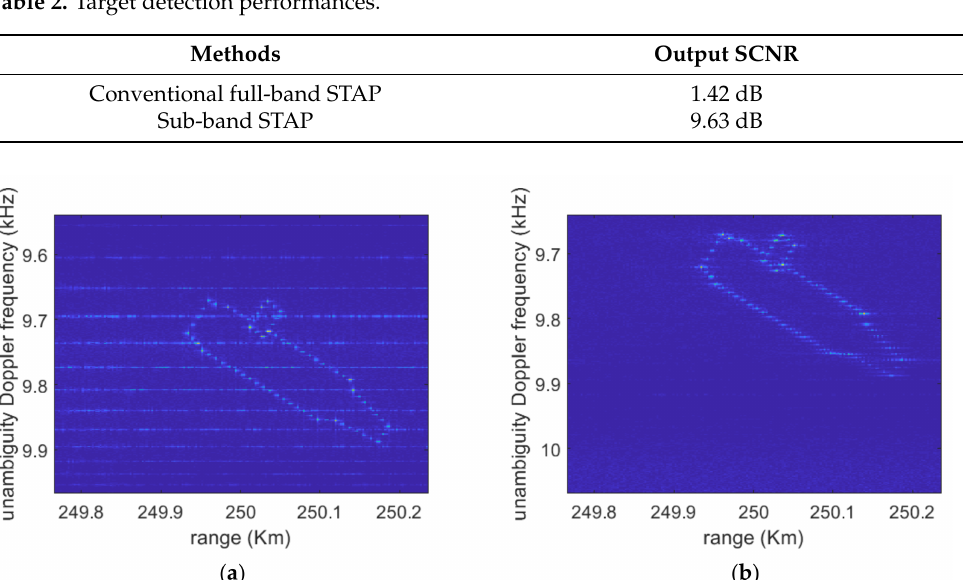
Table 2. Target detection performances.